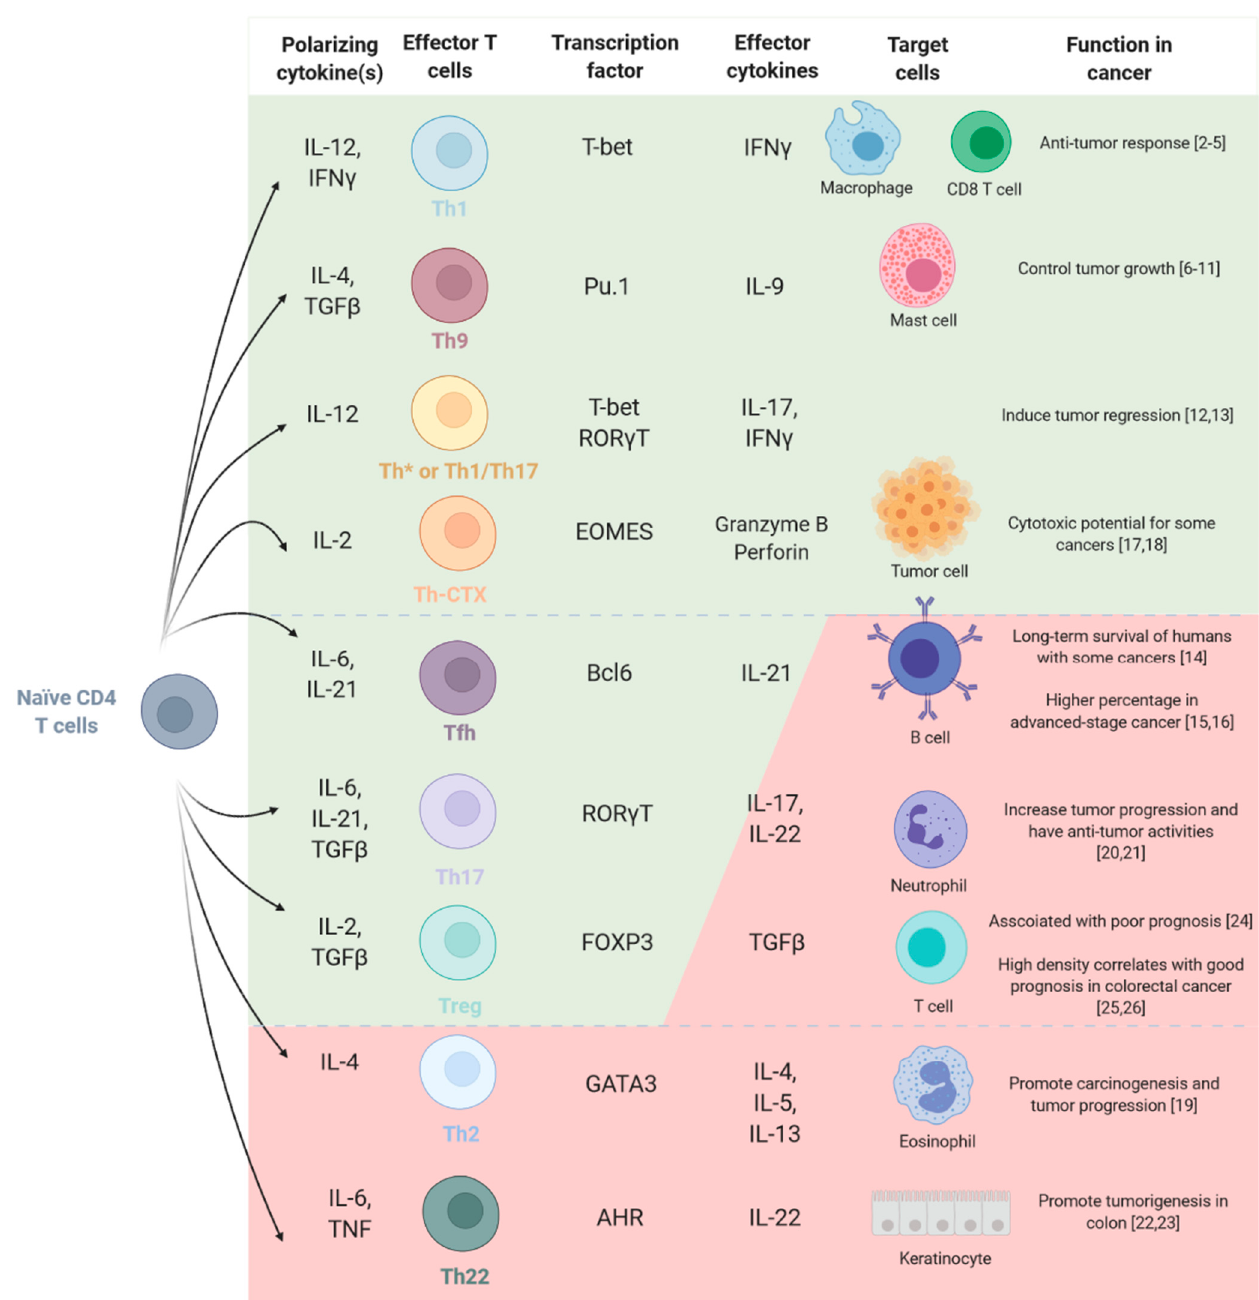
Figure 1. CD4 T cell subsets and tumor immunity. Each CD4 T cell polarization can be defined by the secretion of cytokines and the presence of a master transcription factor. The polarization of CD4 T cells is influenced by the TME and is linked with either tumor-promoting (red) or -suppressive functions (green).